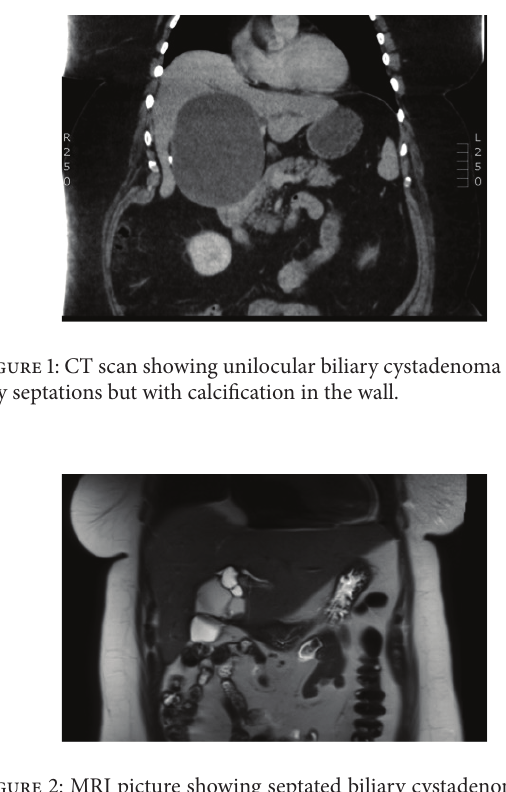
Figure 2: MRI picture showing septated biliary cystadenoma with